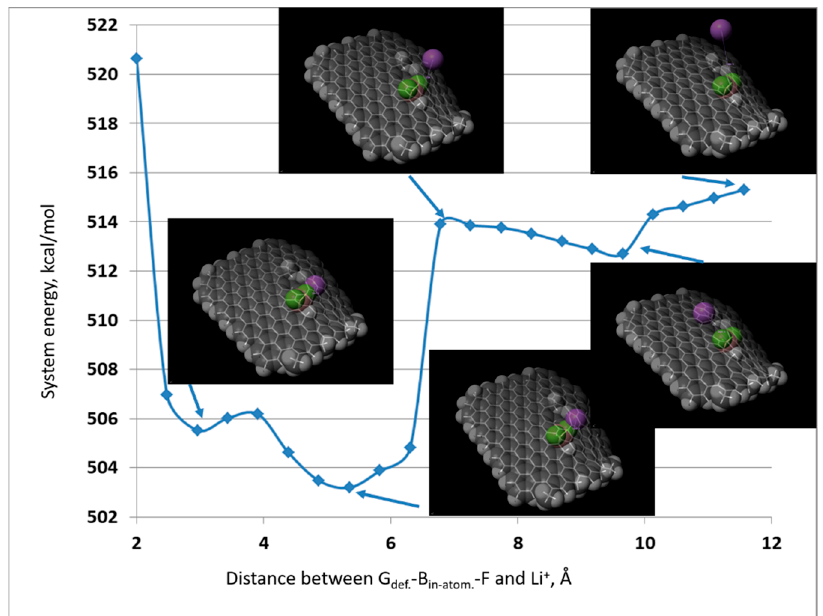
Figure 3. The interaction energy of lithium ions with the structure of Graphene functionalized with -BF 2 group (G def. -B ad-atom -F—according to the nomenclature described in Table 2).